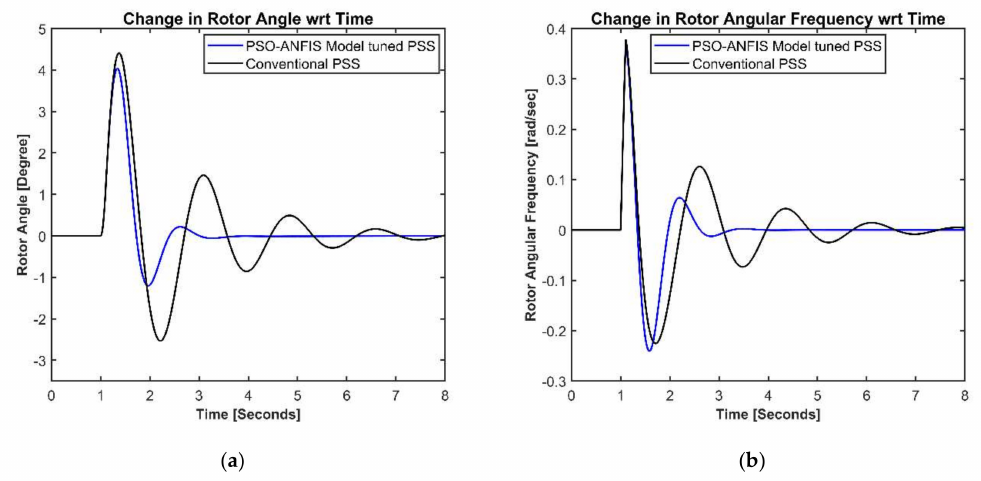
Figure 13. System response for an external disturbance applied at 1.0 s (first network); ( a ) Change in rotor angle and ( b ) Change in rotor angular